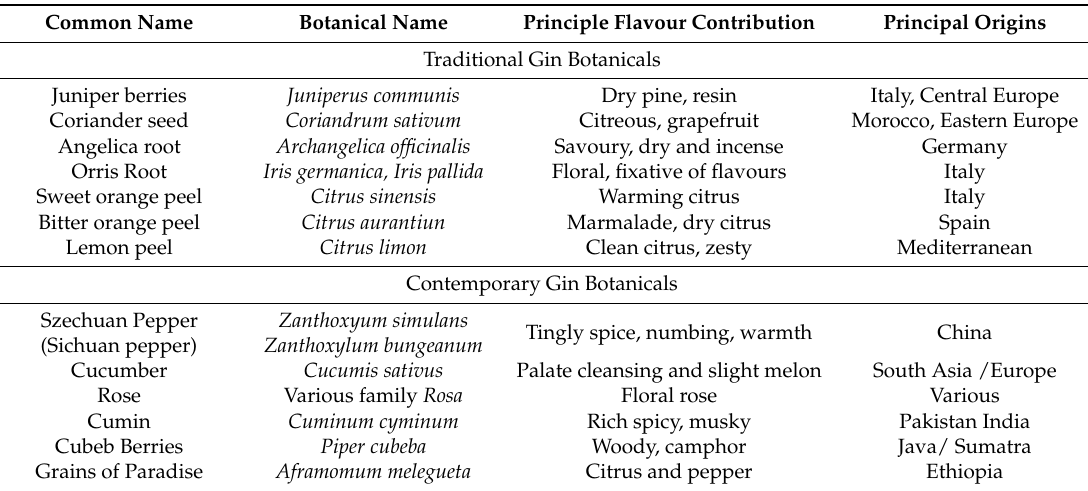
Table 1. Botanicals used in the production of gin